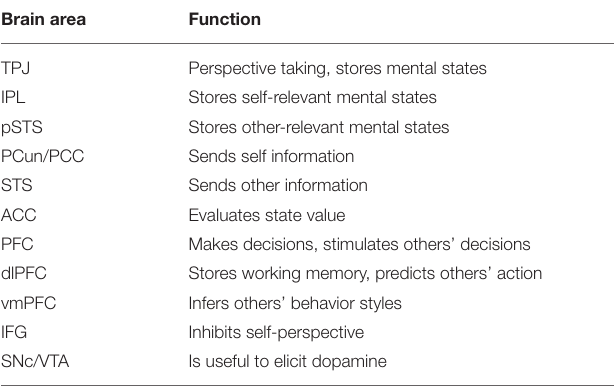
TABLE 1 | The functions of brain